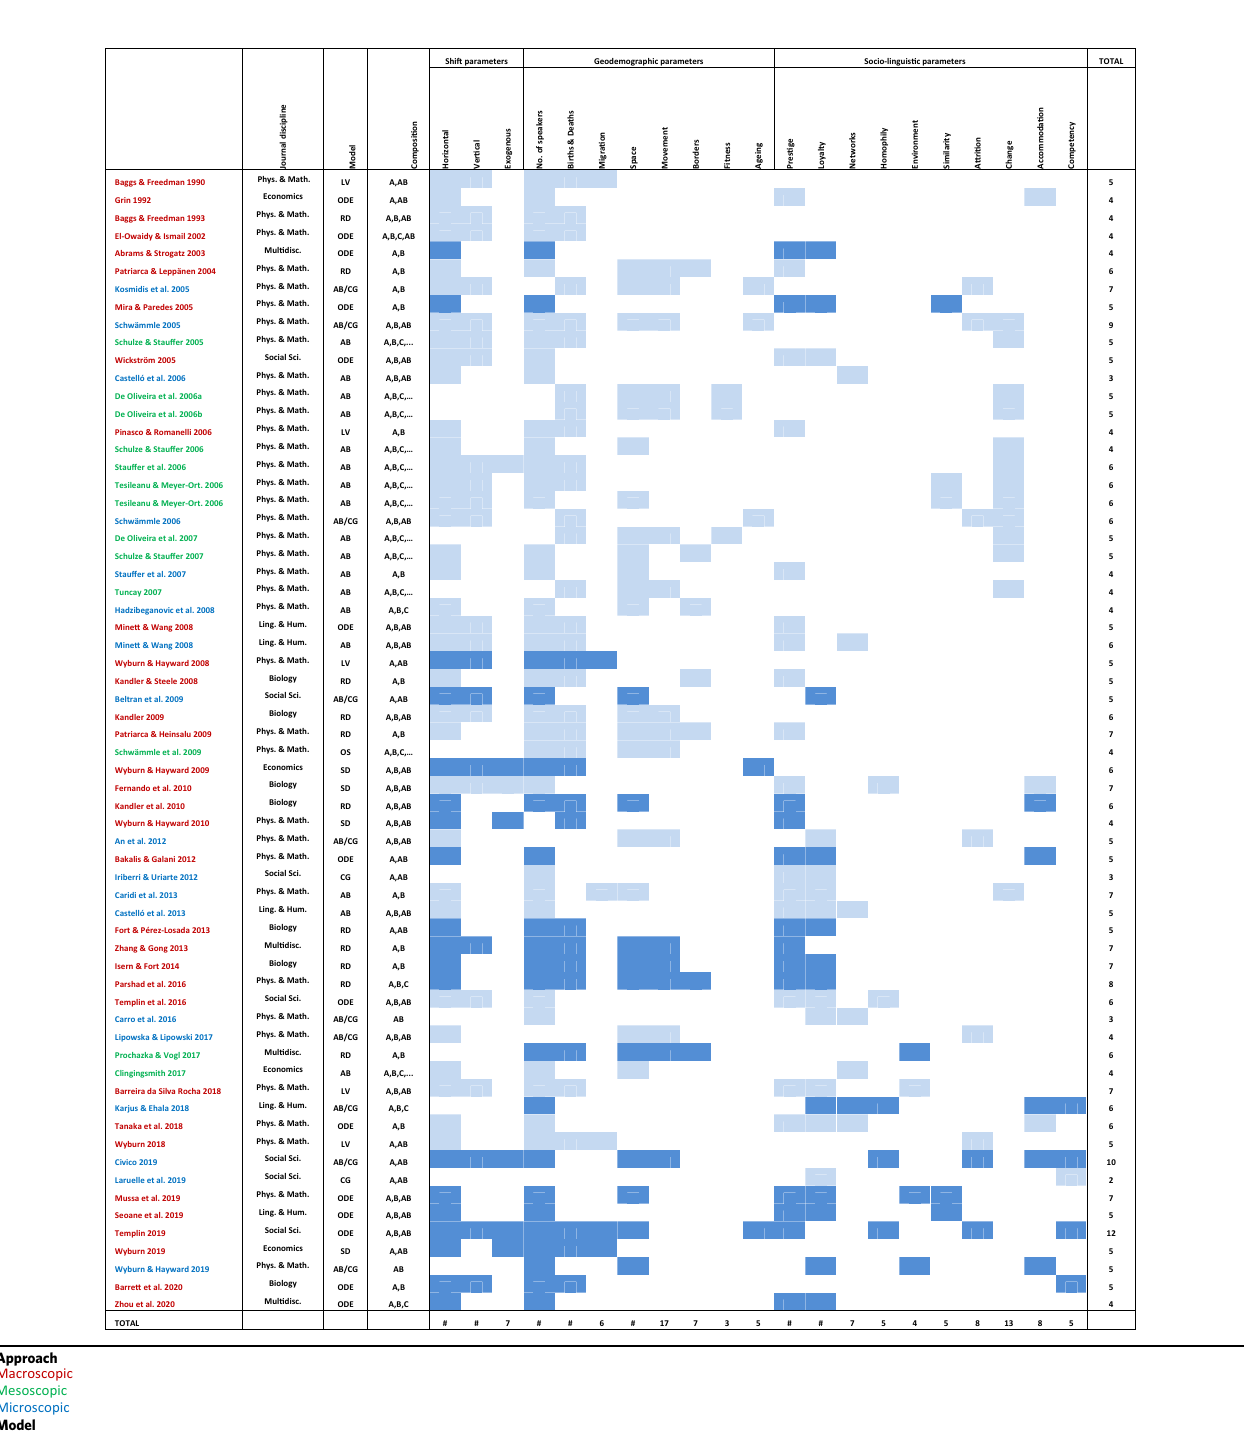
Table 2 Chronological list of studies broken down by type of approach, model employed, composition of the population by linguistic groups, use of data and